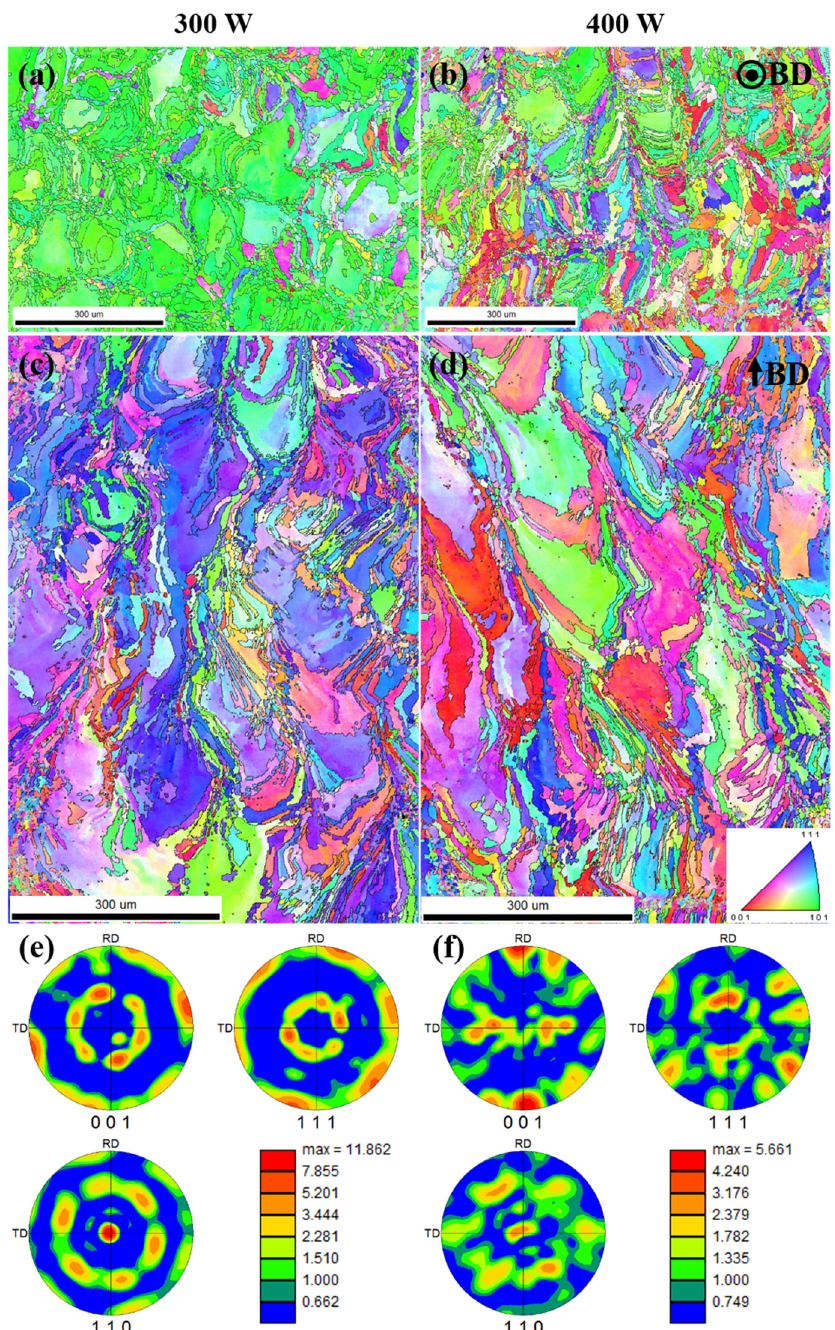
Figure 10. EBSD analysis results for Cu–Cr–Nb–Ti alloy samples manufactured using different laser powers (scanning speed of 800 mm/s): ( a , b ) are IPFs of XY planes of the samples manufactured using laser powers of 300 W (P 300 V 800 ), and 400 W (P 400 V 800 ), respectively; ( c , d ) are IPFs of XZ planes of samples; ( e , f ) are the PFs of XY planes of samples.